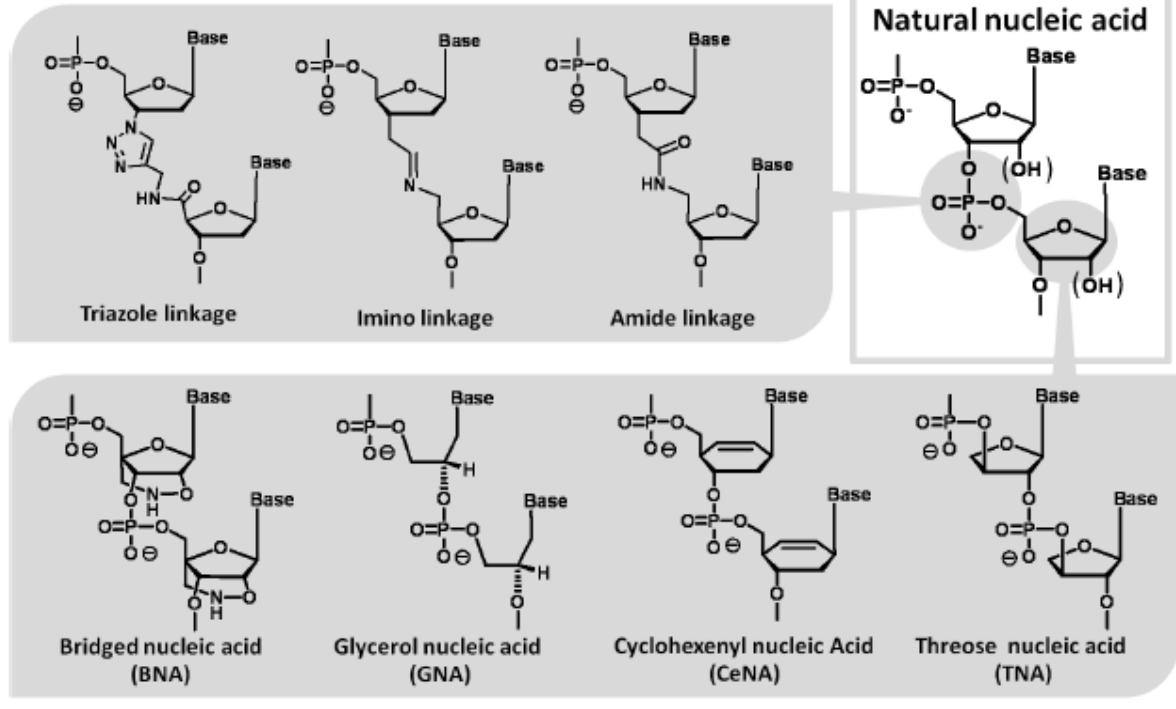
Figure 6. Modified nucleotides with unique chemical structures which act as a template in the polymerase